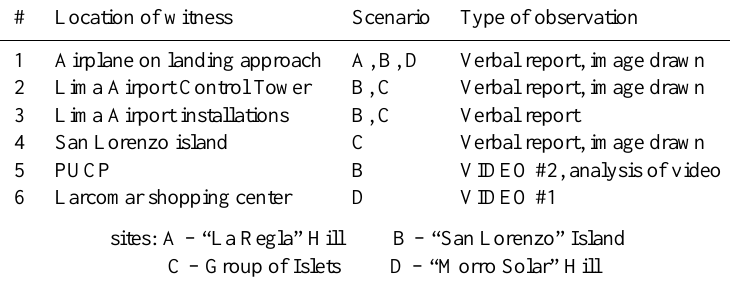
Table 2. Evidence by witnesses and